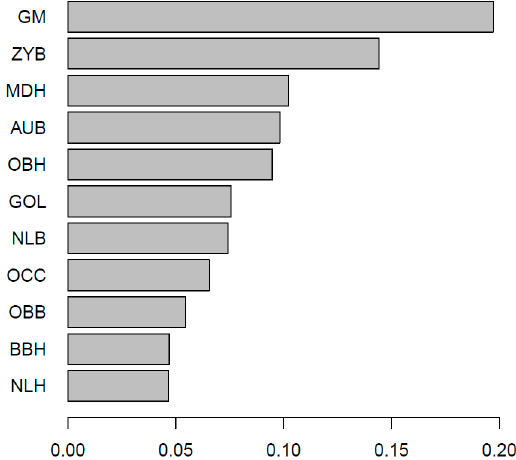
Figure 6. Relative importance of each feature in the best model selected. The importance is shown as a percentage. (GM: geometric mean; ZYB: bizygomatic breadth; MDH: mastoid height; AUB: biauricular breadth; OBH: orbit height; GOL: glabella-occipital length; NLB: nasal breadth; OCC: lambda-opisthion chord; OBB: orbit breadth; BBH: basion-bregma height; NLH: nasal height).